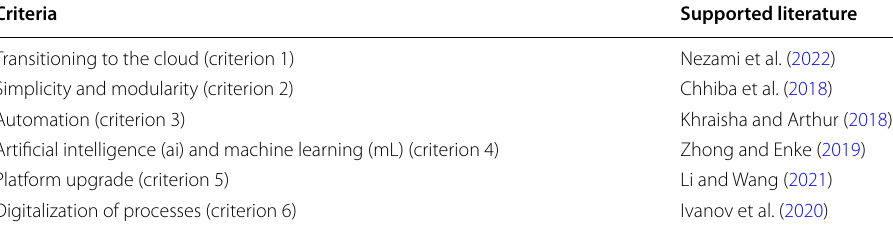
Table 9 Selected criteria for the open innovation-based fintech potential Criteria